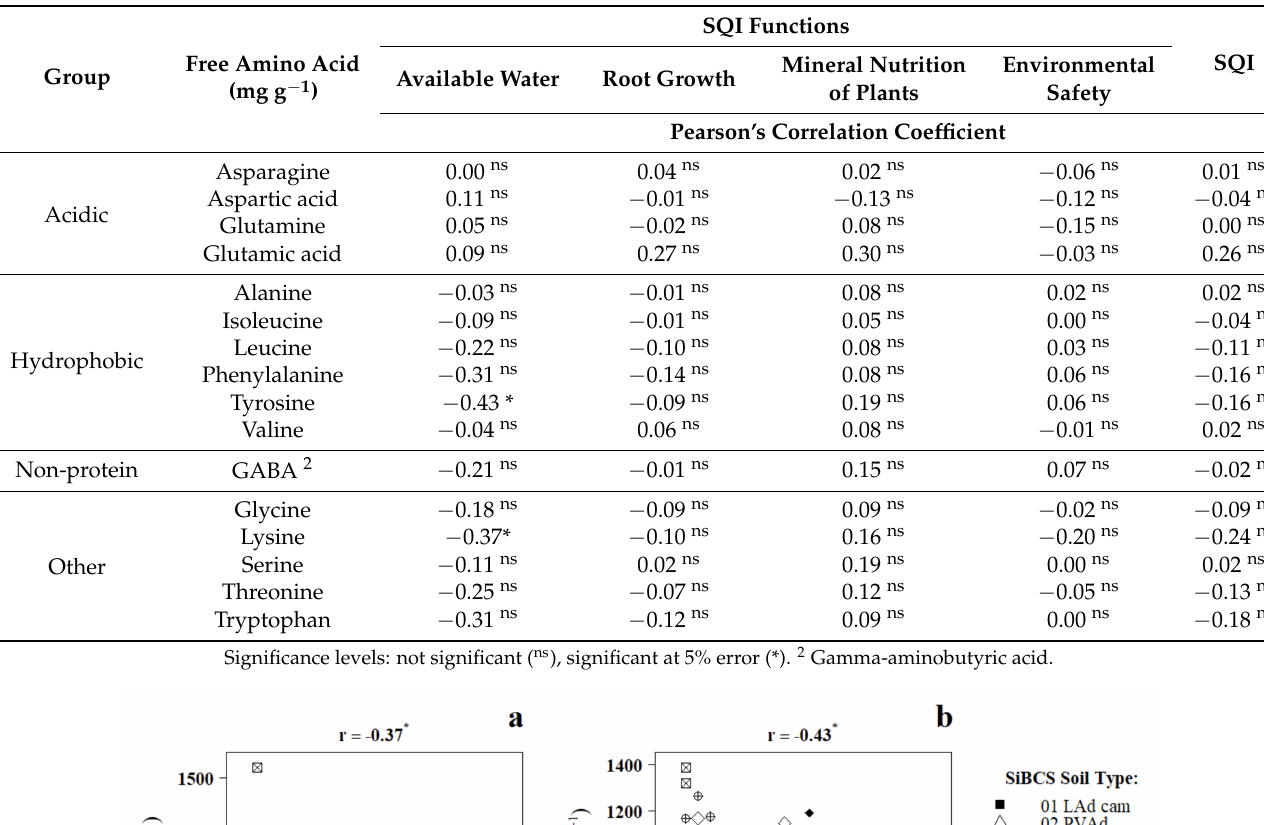
Table 5. Pearson (r) linear correlations between free amino acids in PH-16 dry cacao beans and Soil Quality Index (SQI) and its functions (0–15 cm) in 12 crop sites in the humid zone of southeast Bahia, Brazil.